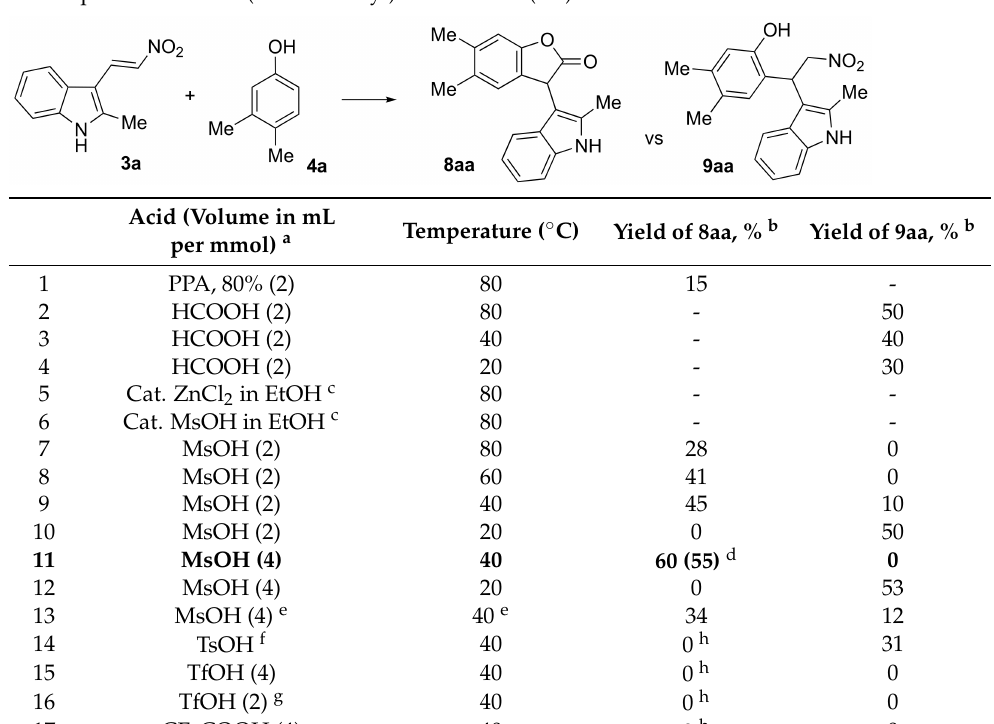
Table 1. Optimization of the reaction conditions for a direct conversion of 3-(2-nitrovinyl)-1 H